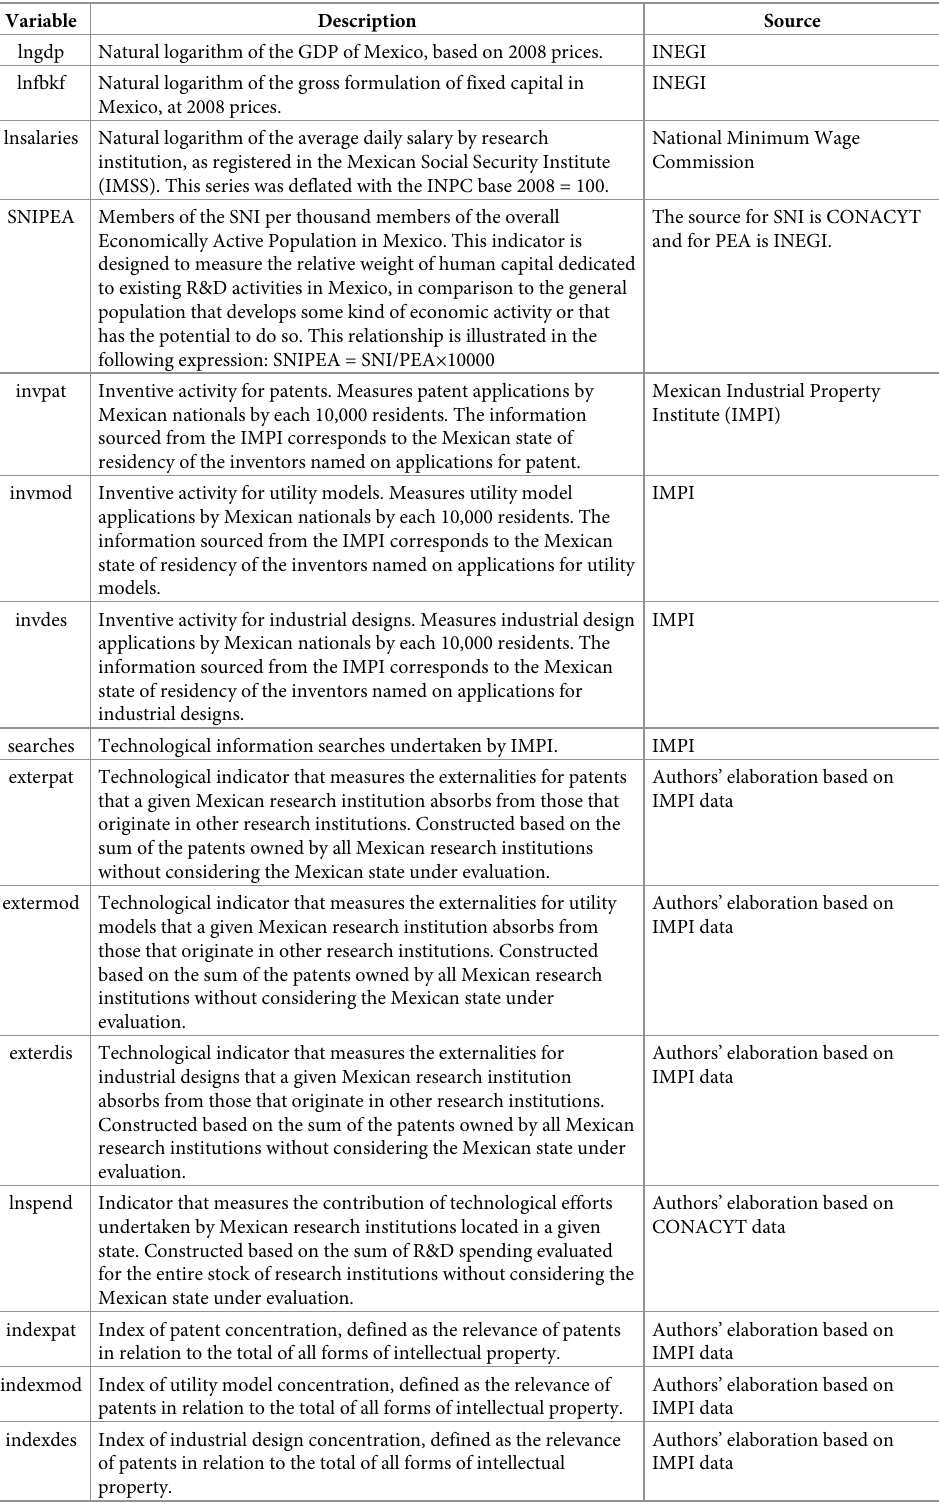
Table 1. Description of the